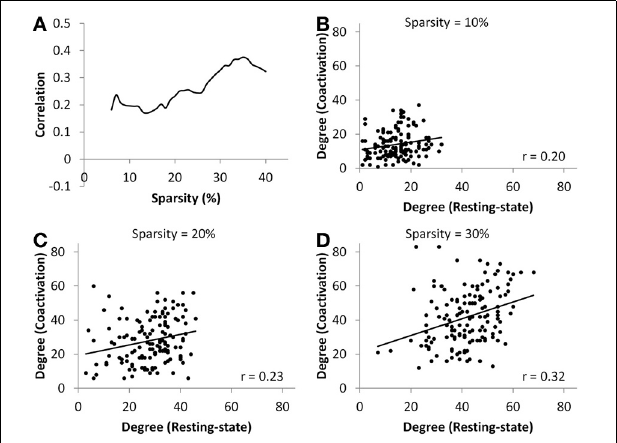
FIGURE 4 | (A) Correlations between nodes’ degree of the coactivation network and the resting-state network as a function of connectivity sparsity. Panels (B–D) show the scatter plots of node degrees between the two networks at sparsity level of 10% (B) , 20% (C) , and 30% (D) , respectively. The lines in the scatter plots represent the linear fit.